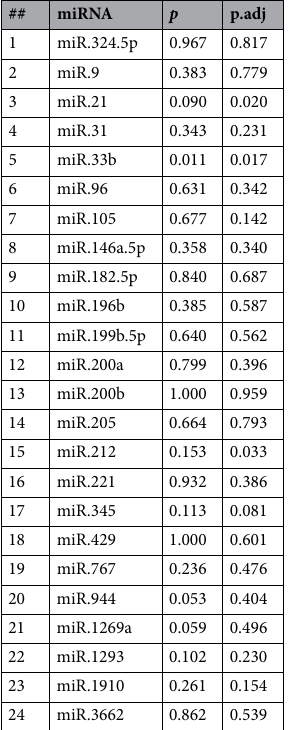
Table 3. Logistic regression, univariate miR, All subjects, n = 351. The univariate models included adjustments for clinical factors of age, gender, smoking status (current, former, never), smoking pack-years and quit-years, and underlying lung disease. Underlying lung disease: For all models, underlying lung disease was treated as trichotomous (COPD /fibrosis//inflammation NOS, asthma) versus sarcoidosis/bronchiectasis) versus none/ other. Housekeeper transcript miR423-5p is not